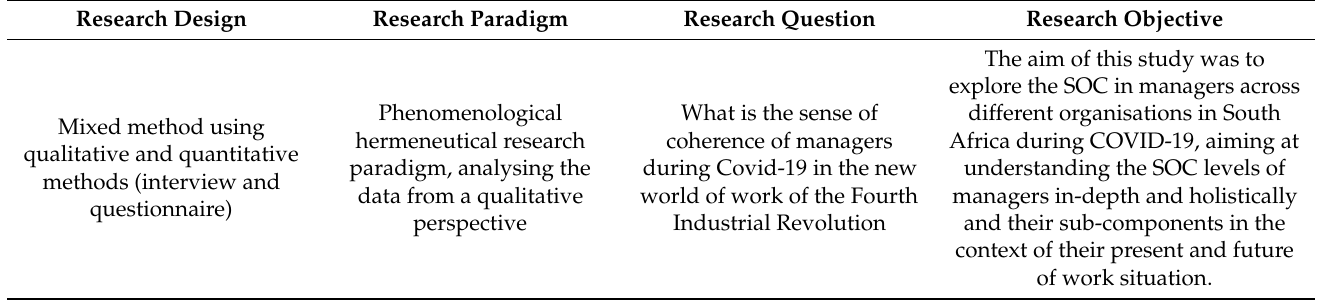
Table 1. Overview of Research